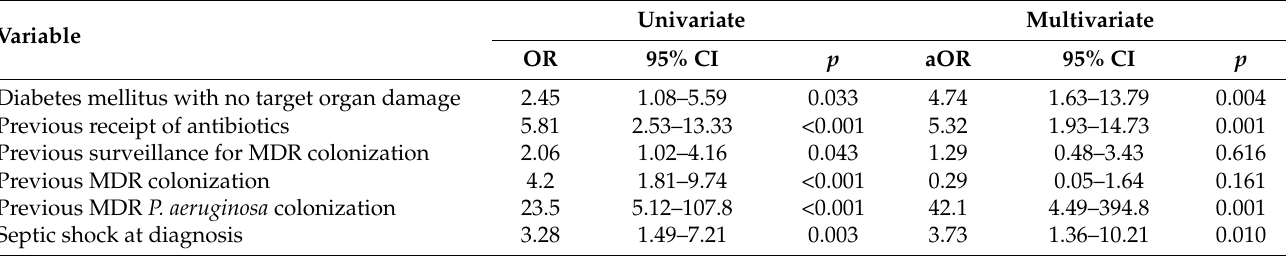
Table 3. Univariate and multivariate analysis of risk factors associated with MDR-PSA infection.